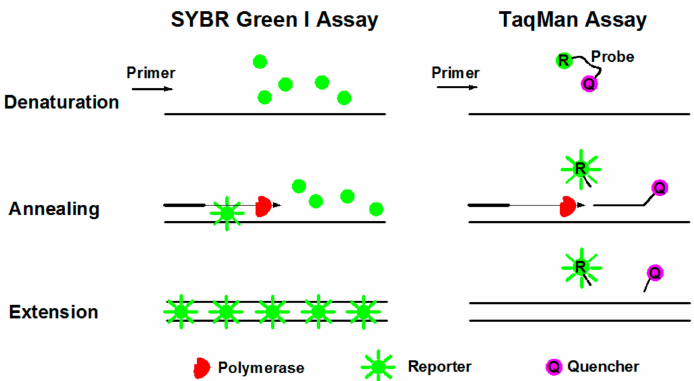
Figure 5. Schematic diagrams of SYBR Green I and TaqMan assays during PCR procedures of denaturation, annealing, and extension.